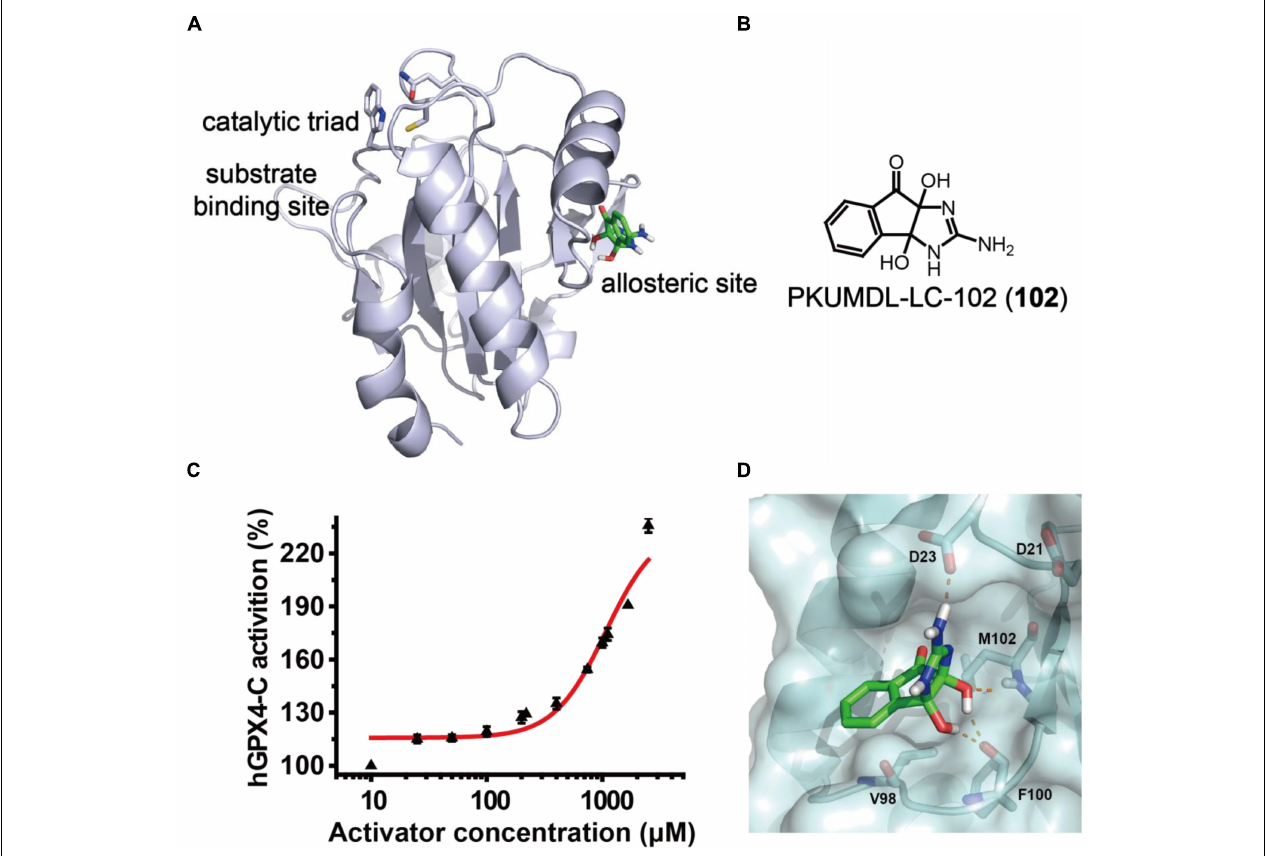
FIGURE 2 | GPX4 activator identification. (A) The predicted allosteric site using CAVITY and CorrSite is on the opposite side from the substrate-binding site across the protein. The catalytic triad C46, Q81, and W136 in the substrate-binding site are shown as sticks. The allosteric activator is shown in green. (B) Chemical structure of compound 102 . (C) Dose–response curve for compound 102 in cell-free assay using hGPX4-C. Data shown represent the mean ± standard error of mean (SEM; n = 6). (D) Predicted binding mode of compound 102 . The hydrogen bonds between the activator (green) and hGPX4-C (pale cyan) are shown as orange dashed